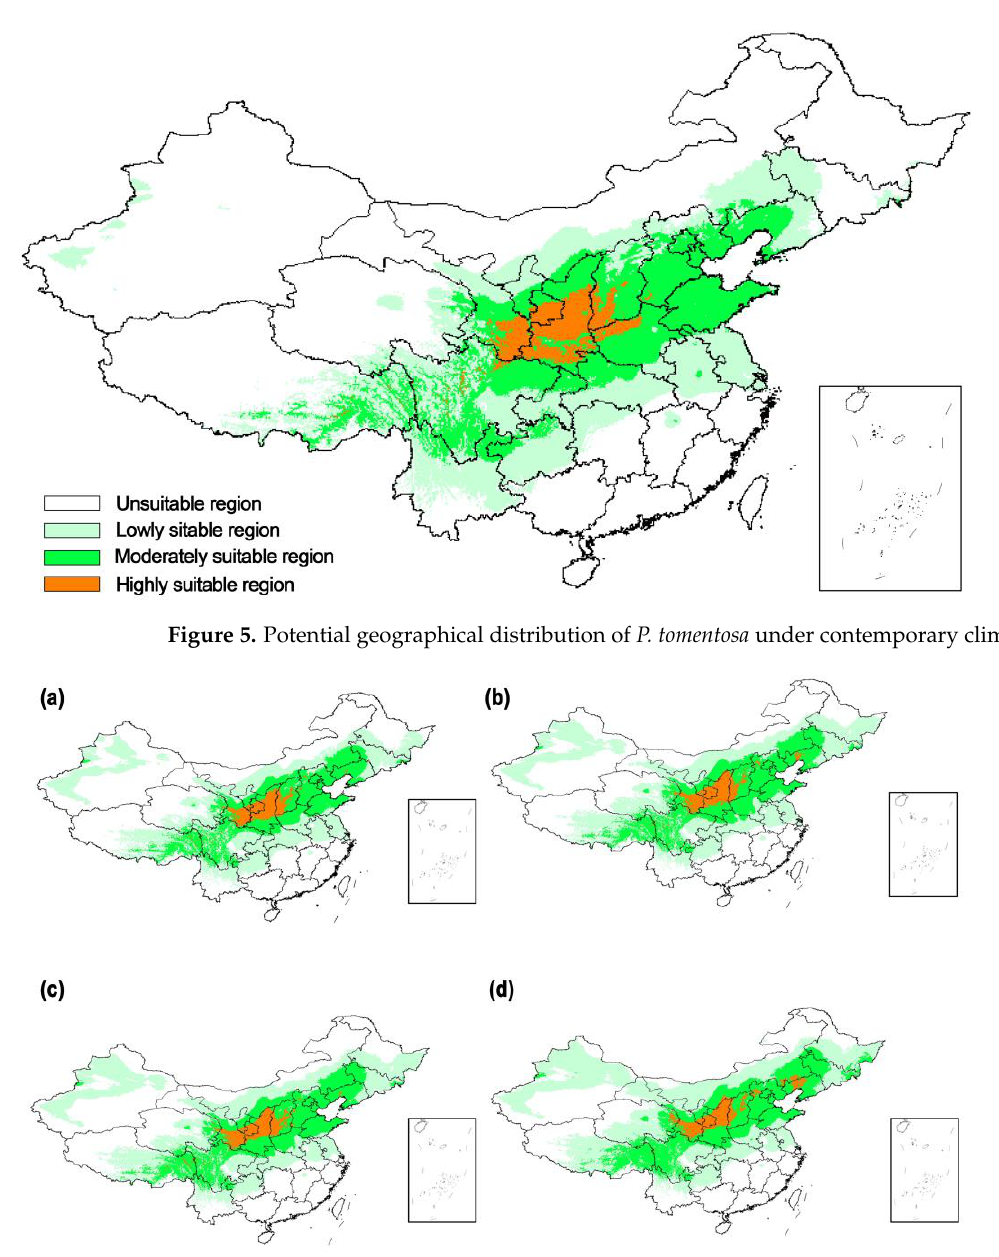
Figure 7. Low impact area under different RCP in the future. ( a ) Low impact area (LIA)-RCP4.5, ( b ) Low impact area (LIA)-RCP8.5. 4. Discussion 4.1. The Impact of Model Complexity on Model Accuracy When the prediction model fits the test set too closely in the environment space, the training set cannot be predicted truly and independently, and overfitting is prone to oc- cur. Similarly, models that do not match (models with inappropriate complexity) cannot provide sufficient distinction, therefore the predictive performance of the model is poor.